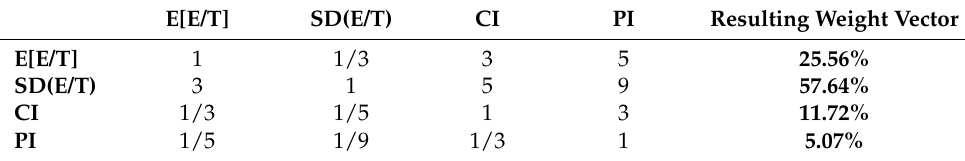
Table 6. Example of AHP scores and the resultant priority